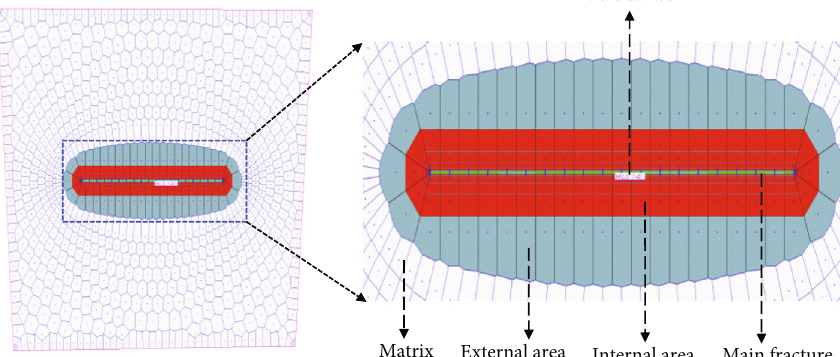
Figure 1: Schematic diagram of fracture meshing in the stimulated